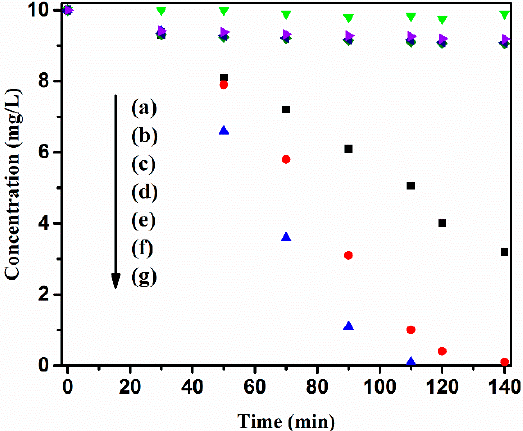
Figure 6. Time profiles of photocatalytic degradation of MB for ( a ) without photocatalyst; ( b ) H-400; ( c ) V-400; ( d ) P25 without irradiation; ( e ) P25; ( f ) V-400; and ( g ) H-400 under 1.5 G solar light illumination.